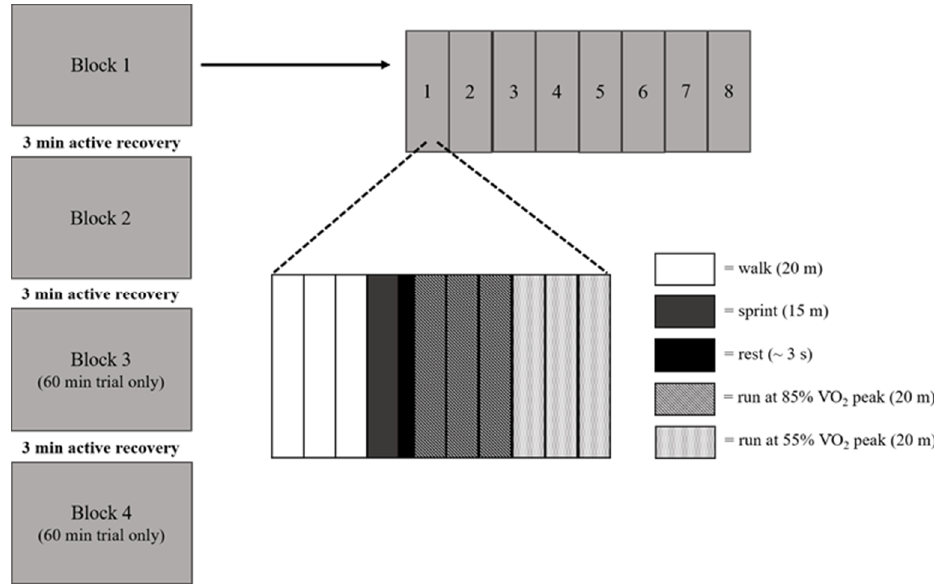
Figure 2. LIST protocol (adapted from Nicholas et al.,